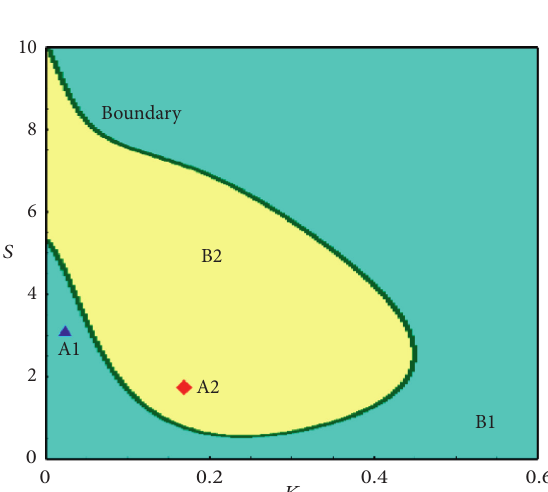
Figure 1: The global dynamic character of system (4): b � 0 . 75. b s